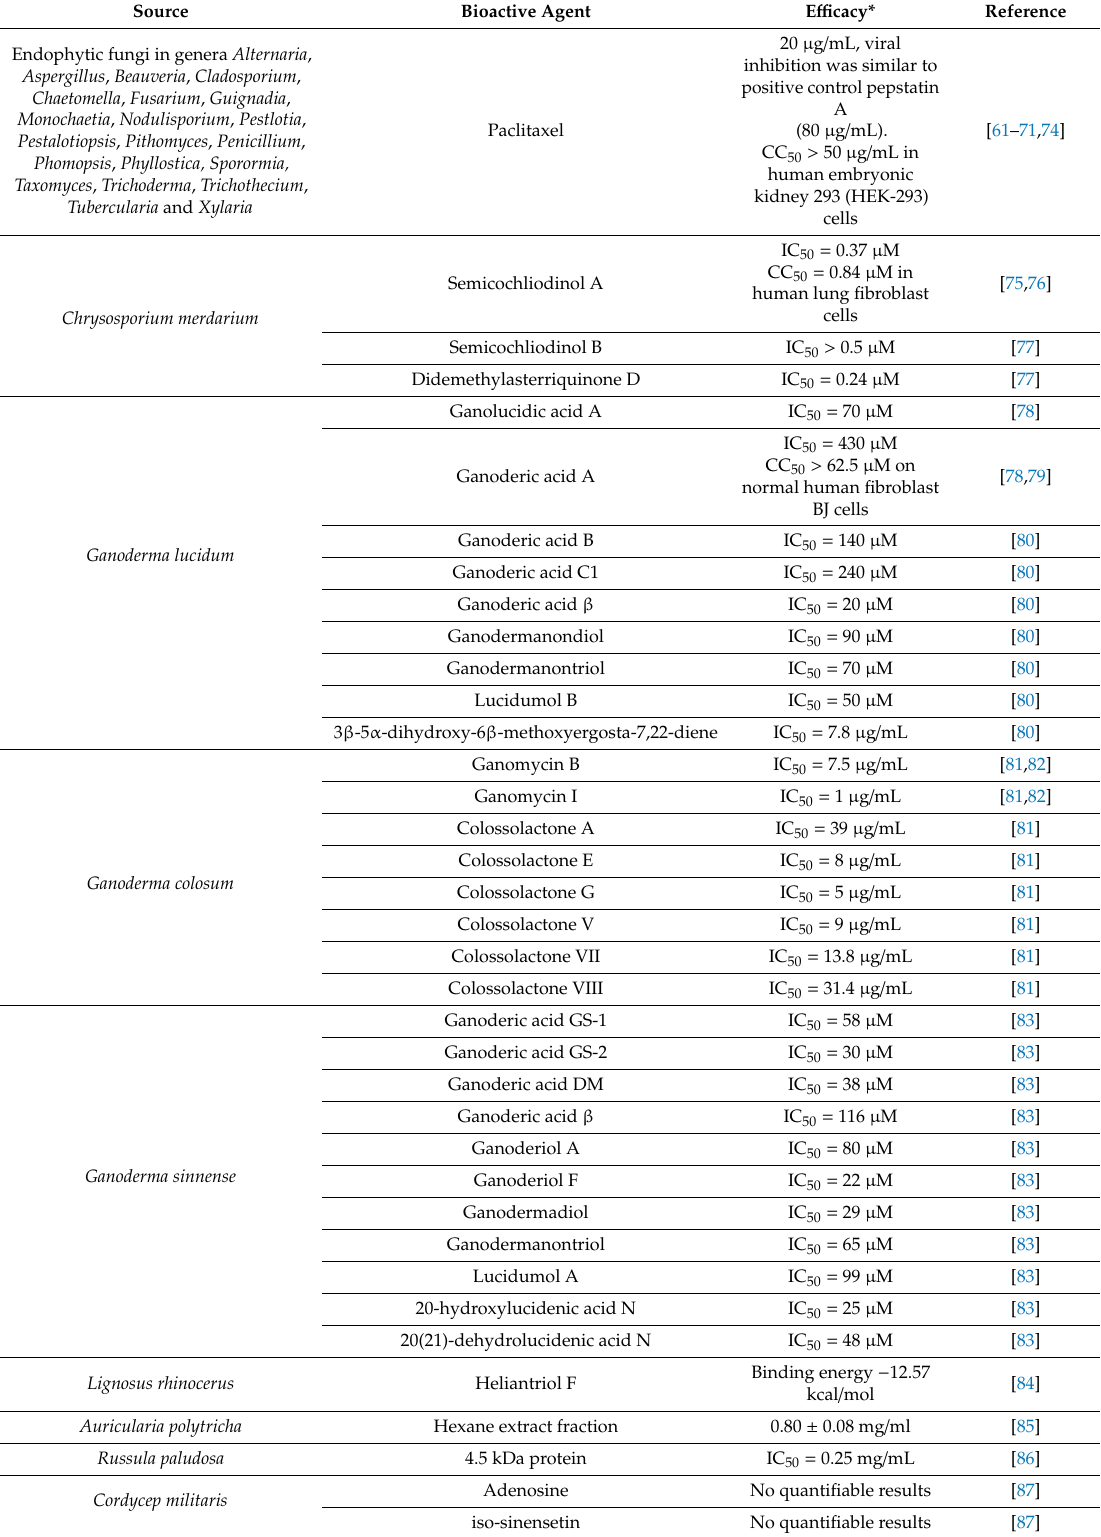
Table 1. Fungal bioactive compounds for HIV-1 protease inhibitors that potential candidate to treat